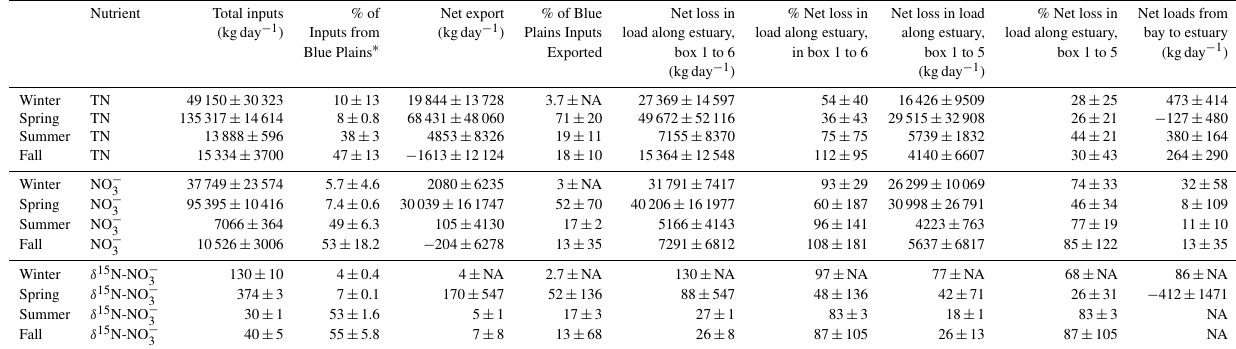
TN:totalnitrogen.NAindicatestherewaseithernodataoronlyonemonthwithdataforthatseasonandthusnoSEvalue. ∗ BluePlainsisawastewatertreatmentplant.